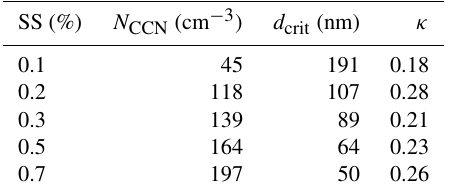
Table 1. Median values of N CCN , d crit and κ for different SS. Val- ues for SS = 0.1% are calculated using the unfiltered data that cover the entire measurement period, whereas the values for SS = 0.2, 0.3, 0.5 and 0.7% are calculated using the filtered data of periods 1, 2 and